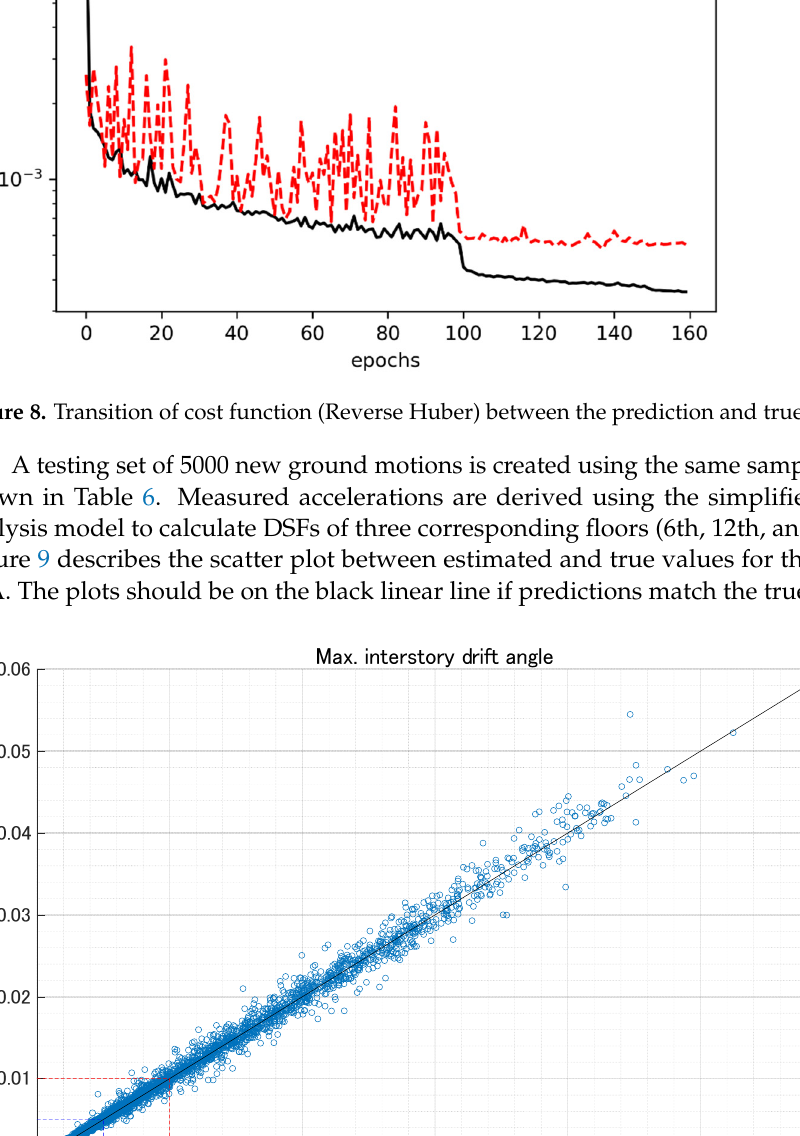
Figure 10. Safety evaluation using the confusion matrix. 3.6. Validation Results Using Experimental Data This section further validates the CNN trained in Section 3.5 using the experimental data listed in Table 3 (totally seven experimental cases). The DSFs at the 6th, 12th, and 18th floor are computed using the measured acceleration and the acceleration predicted by the simplified linear analysis model. Then, the trained CNN is applied to the ground acceleration and the corresponding DSFs to estimate the maximum IDA. Finally, safety classification is performed based on the estimated maximum IDA to check the accuracy of the proposed framework. To demonstrate the effectiveness of nonparametric system identification for the pre- dicted linear analysis model, comparisons of time history response accelerations are pre- sented in Figure 11 using results of experimental case 1 in Table 3. The simplified linear analysis model is updated using the nonparametric system identification (SRIM method) to match measured time history response accelerations. Figure 11 shows that applying the